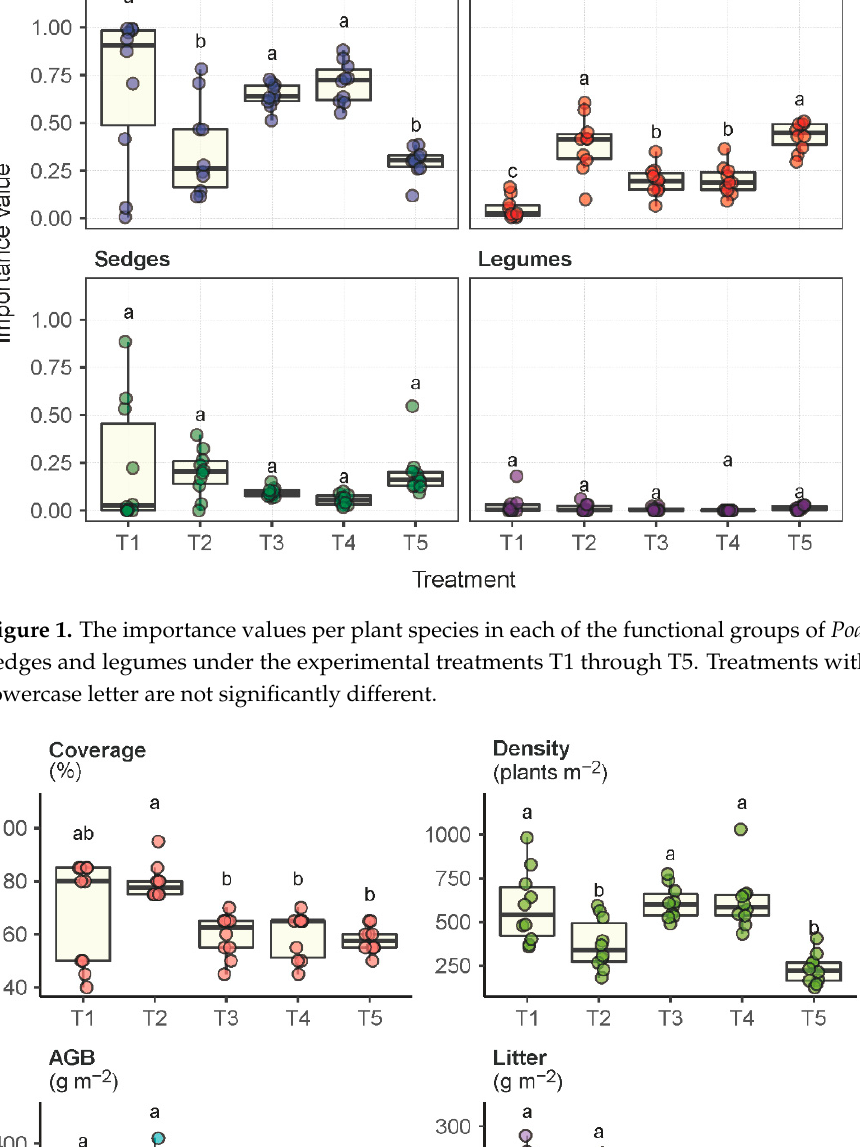
Figure 2. Plant community properties of coverage, density, aboveground biomass (AGB) and litter accumulation in response to the experimental treatments T1 through T5. Treatments with the same lowercase letter are not significantly different.